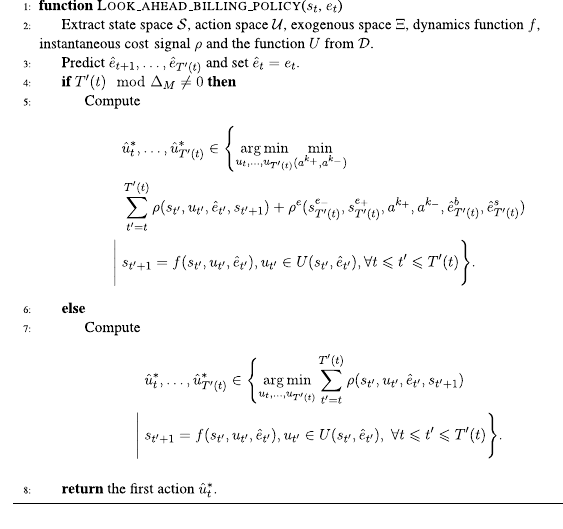
Algorithm3. Look-ahead-billingpolicyfordecisionprocess D andpolicyhorizon